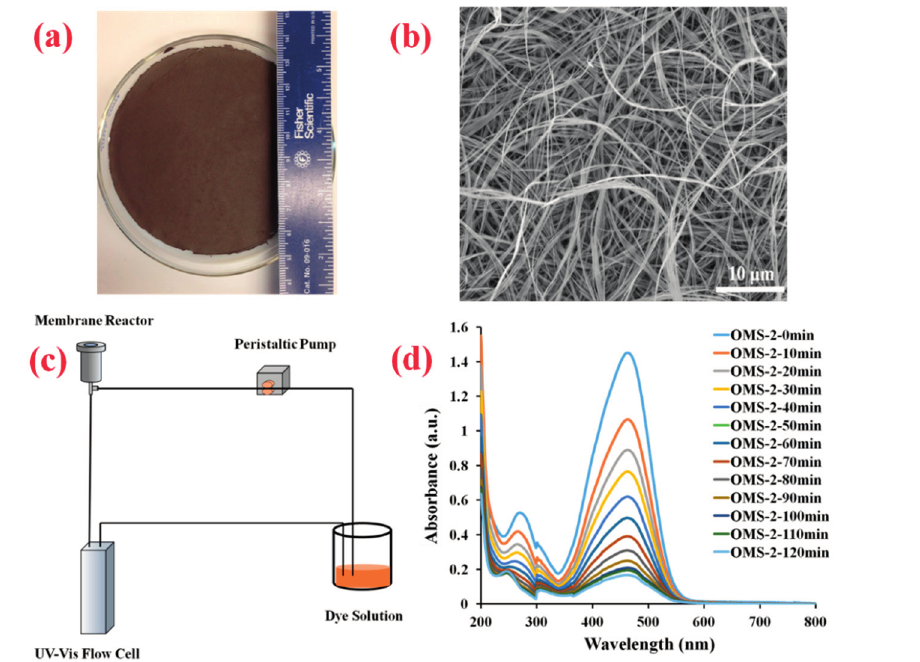
Figure 14. MnO 2 nanowire membrane for dye degradation: ( a ) overall view of MnO 2 nanowire membrane; ( b ) SEM image of the MnO 2 nanowire membrane; ( c ) in-situ membrane reaction system; ( d ) the UV-Vis spectra of the catalytic degradation of methyl orange by MnO 2 nanowire